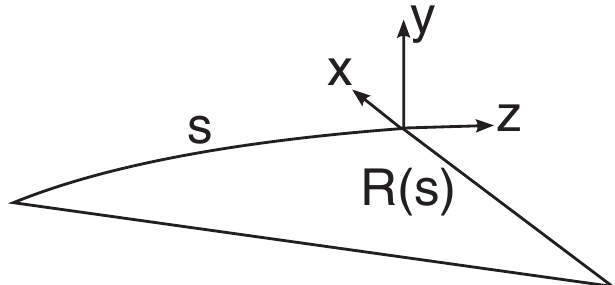
FIG. 1. Accelerator coordinate system. At any given distance s along the reference trajectory, we can assume a local radius of curvature R (cid:2) s (cid:3) . Deviations in the transverse directions are given by x (in the bending plane) and y (perpendicular to the bending